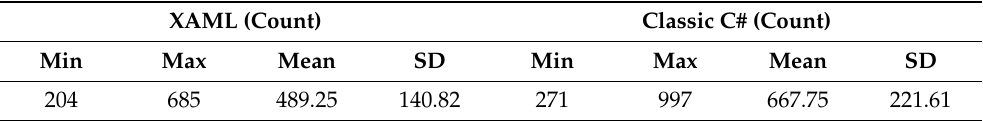
Table 3. The descriptive statistic of the number of fixations based on XAML and classic C# ( n = 36).